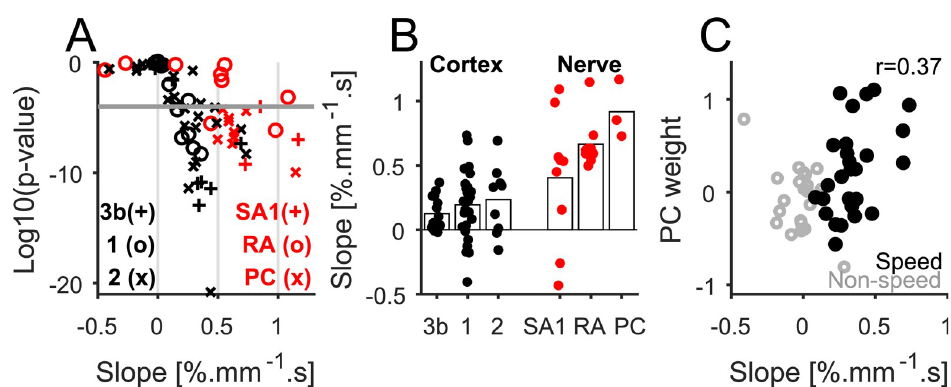
Fig 7. Speed coding in single cortical units. (A) p -Value versus normalized regression slopes for each neuron. Black denotes cortical neurons, and red denotes nerve fibers. Marker type denotes cortical field or fiber type (see legend). The gray line denotes the threshold for significance (10 − 4 ). (B) Regression slope for each neuron, classified by area and fiber type (bars show the mean across neurons). (C) PC weight as a function of regression slope for each neuron. Neurons with higher PC input tend to be more sensitive to speed. Data underlying this figure can be found in S1 Data. PC, Pacinian corpuscle–associated; RA, rapidly adapting; SA1, slowly adapting type 1.